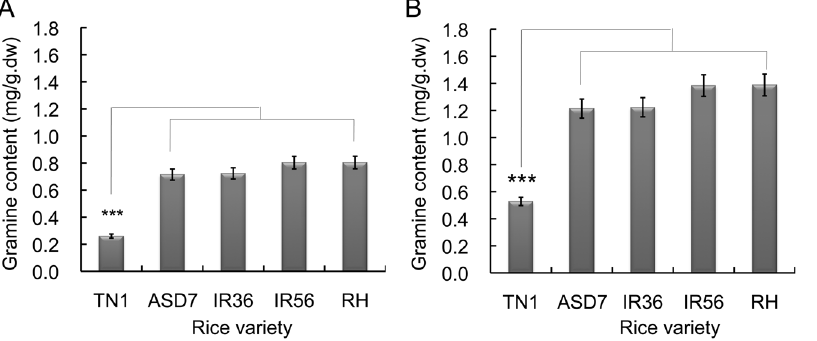
Figure 1. Gramine content in various rice cultivars. Gramine content was extracted from brown planthopper (BPH)-resistant and BPH- susceptible rice varieties at the seedling ( A ) and tillering ( B ) stages. The gramine content was determined by HLPC approach as described in Materials and Methods . Data represent the means 6 standard deviation (SD) from three independent experiments with triplicate samples (each cultivar containing 10 seedling or tillering rice plants) examined. ***indicates significance at P , 0.001. dw: dry weight. TN1: rice cultivar Taichung Natuva 1 (BPH susceptible); ADS7, IR36, IR56 and RH (Rathu Heenati): BPH resistant rice varieties.